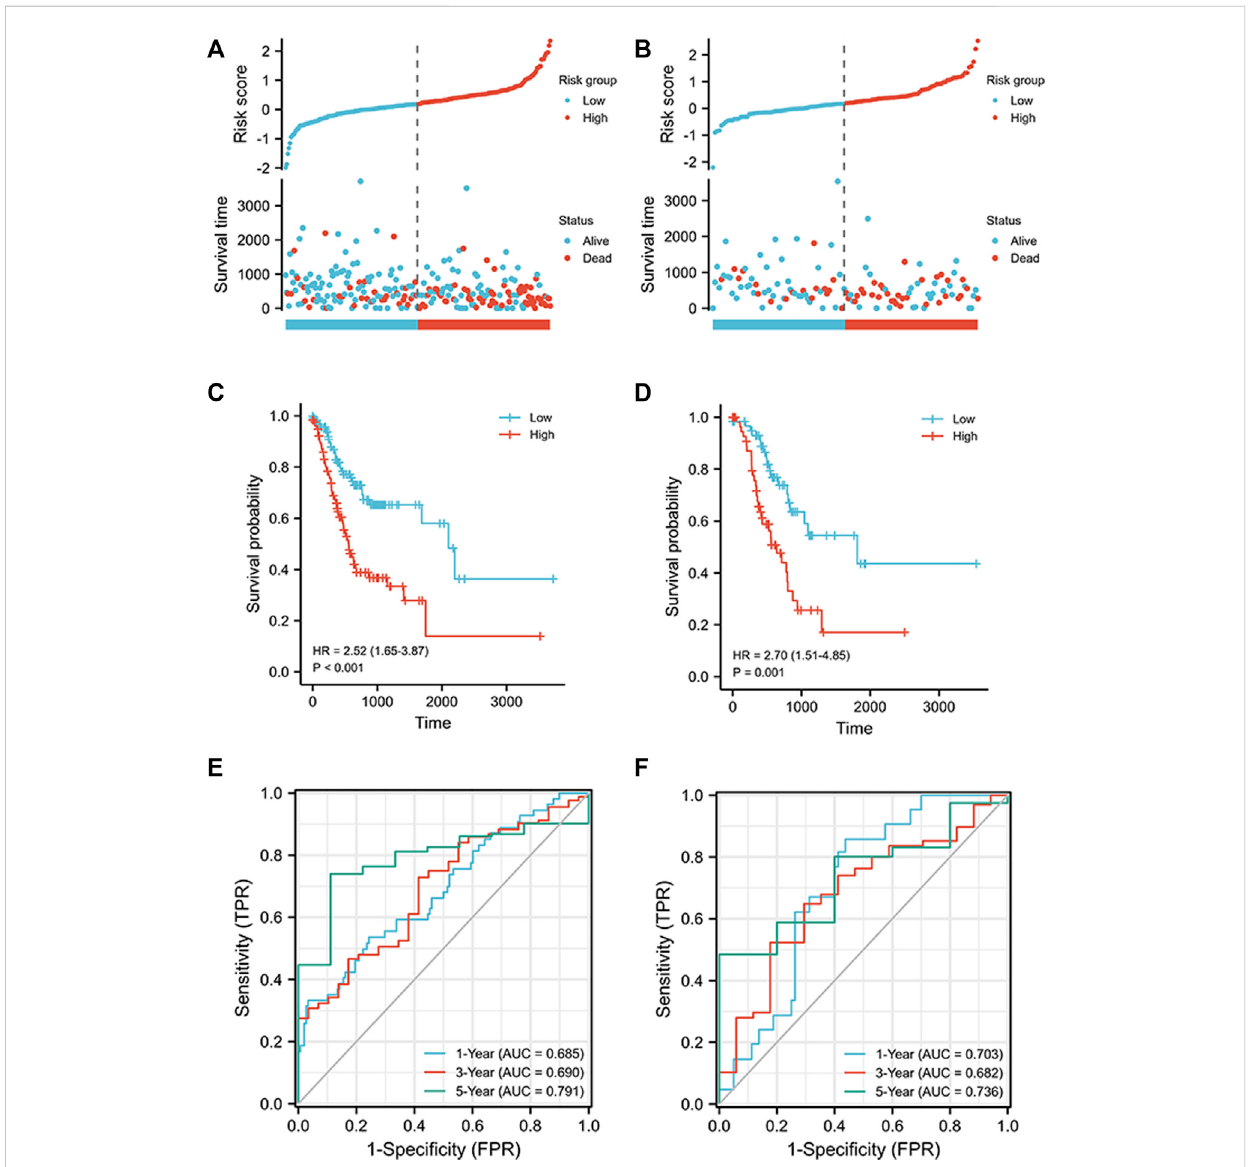
FIGURE 3 PrognosticanalysisofICD-relatedlncRNAsignatureintrainingandvalidationcohorts. (A) Distributionofriskscoresinthetrainingcohortandoverall survival status, overall survival, and risk score. (B) Distribution of risk scores in the validation cohort and overall survival status, overall survival, and risk score. (C) Kaplan – Meier curves for the overall survival of patients in the high- and low-risk groups in the training cohort. (D) Kaplan – Meier curves for the overall survivalofpatients inthehigh- andlow-riskgroupsinthevalidation cohort. (E) AUCoftime-dependent ROC curves verifying theprognostic accuracy of risk scores in the training cohort. (F) AUC of time-dependent ROC curves verifying the prognostic accuracy of risk scores in the validation